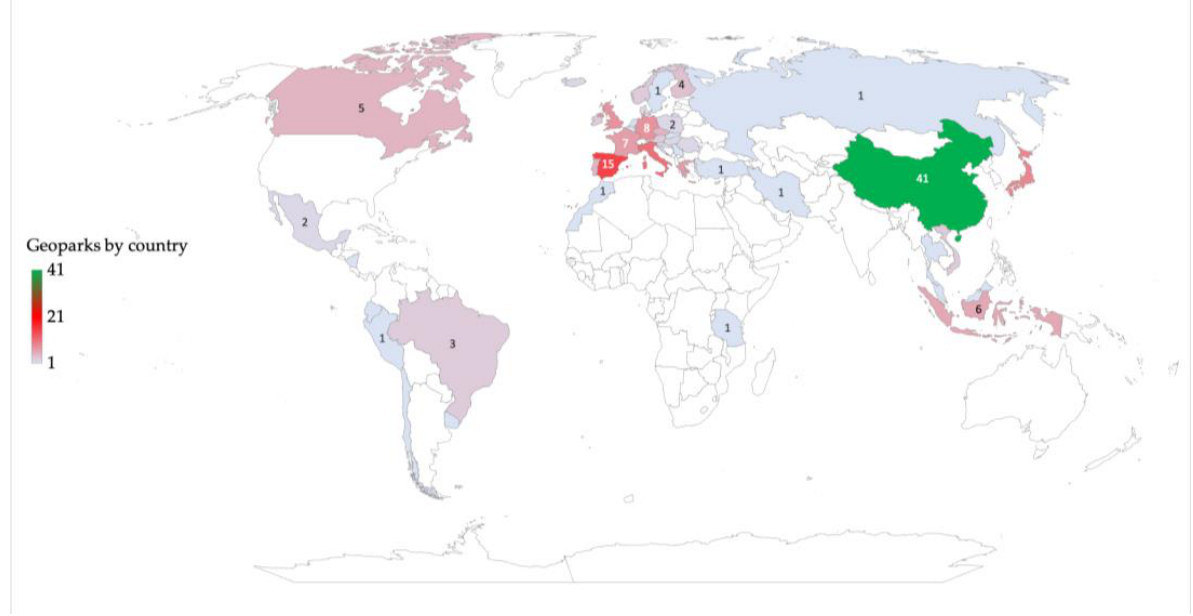
Figure 1. Global Geoparks by country. Source: own elaboration based on UNESCO [4,13].